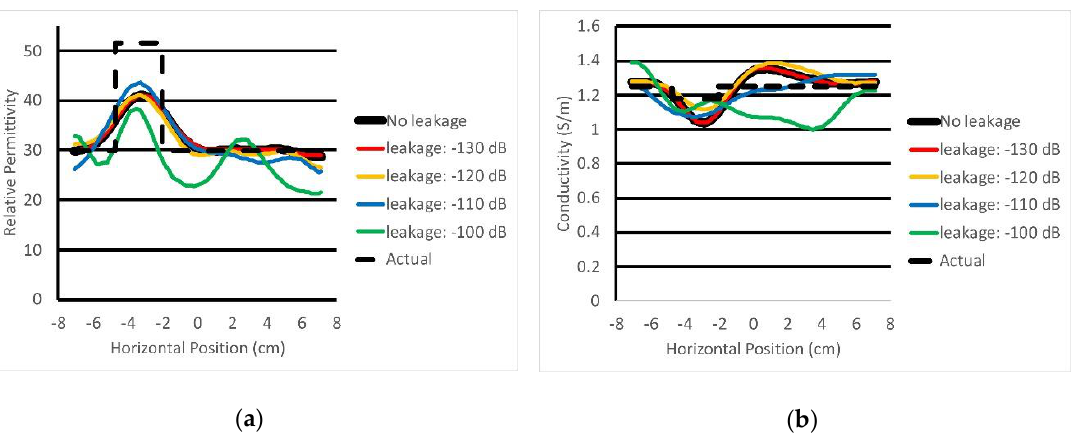
Figure 13. Horizontal transects through the 1100 MHz ( a ) permittivity and ( b ) conductivity images shown in Figure 12.